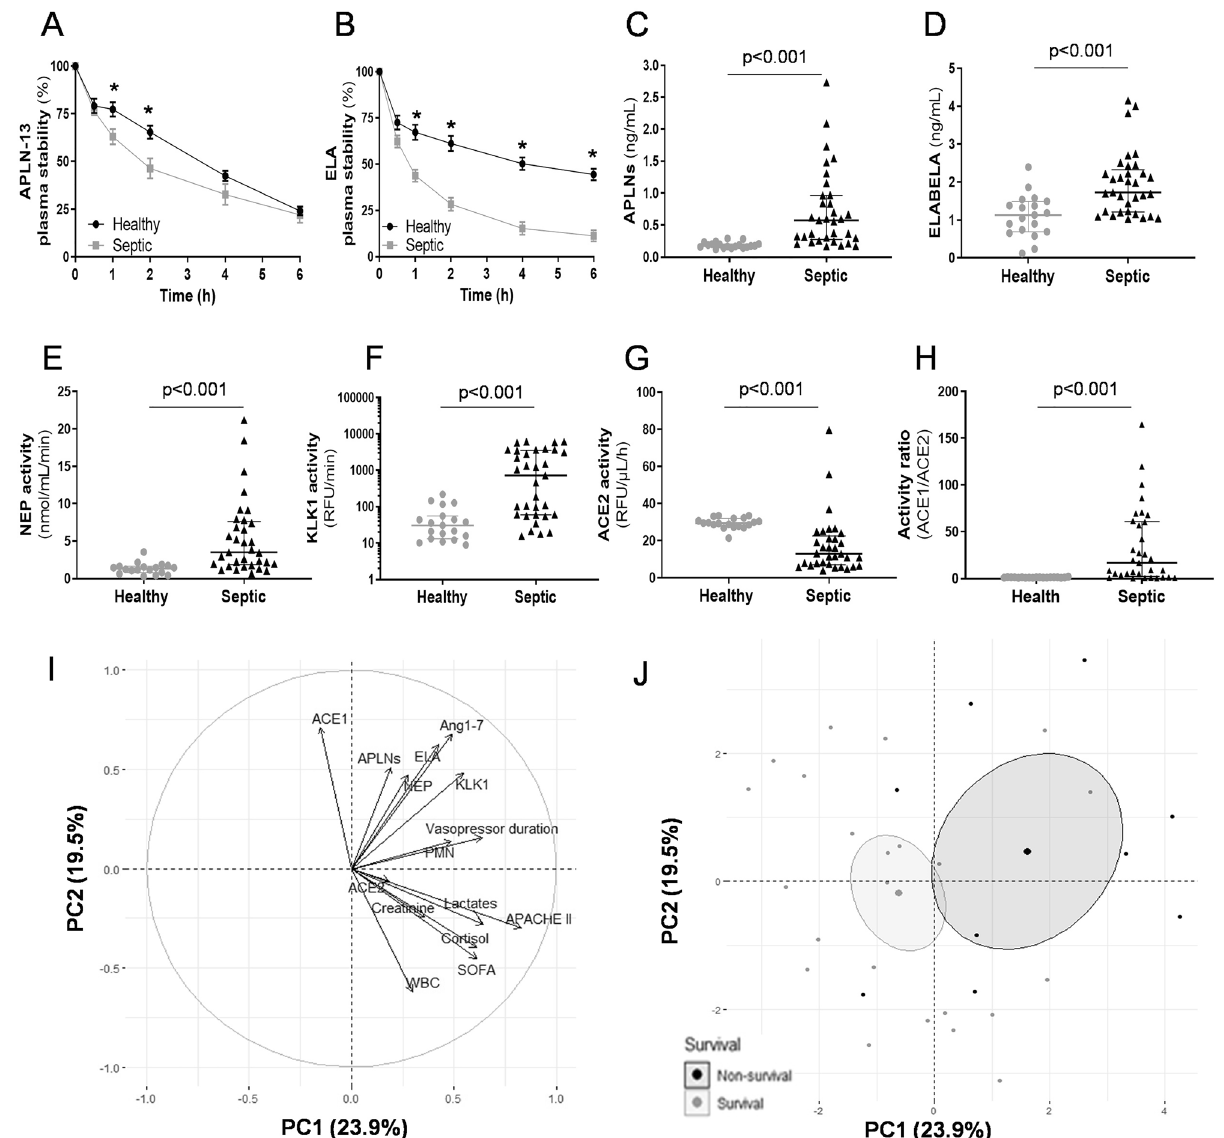
Figure 4. Acute septic shock dysregulated the apelinergic release-degradation rollover and was associated to the activation of specific enzymatic breakdown activities and worsened outcome impacts. A cohort of 33 patients with acute sepsis/septic shock (Sepsis) was included in the study and compared to 19 age-matched healthy volunteers (Healthy) for: (i) assessment of plasma peptide stability; (ii) apelin (APLN) and Elabela (ELA) plasma level determination; (iii) measurement of specific enzymatic breakdown activities; and iv) analyses of the statistical associations between biological; clinical and outcome data. ( A,B ) A randomly selected subset of Sepsis (n = 22) and Healthy (n = 10) plasma were assayed for APLN-13 and ELA stability. The results are expressed as the mean ± SEM. After 1 h incubation, APLN-13 -at two time-points- but also ELA – at four time- points- were more degraded by plasma from septic patients (Sepsis)., *p < 0.05 compared with time-matched values. ( C,D ) Plasma levels of APLNs (all isoforms and moieties) and ELA. Data are displayed as the median [25–75 interquartile range]. Sepsis vs. Healthy induced a higher magnitude of APLN vs. ELA increased levels in bloodstream. ( E–G ) Plasma activities of neprilysin (NEP), kallikrein (KLK1), and angiotensin-converting enzyme 2 (ACE2). ( H ) ACE1/ACE2 enzymatic activity ratio (individual data plots display). Sepsis vs. Healthy enhanced NEP; KLK1; and ACE1/ACE2 enzymatic activity ratio (with decreased ACE2 activity). ( I ) Correlation circle graph of 15 variables related to sepsis outcome from 33 patients and to the apelinergic release-degradation system. Two PCs (PC1 and PC2) were identified in a principal component analysis (PCA), explaining 43% of the variation in the dataset. ( J ) Individual dispersion graph of PCA split by survival status. The midpoint of the concentration ellipses is representative of the gravity center for each modality of survival. Statistical analyses for quantitative variables were performed with a Mann–Whitney U test (nonnormally distributed variables) for panels ( C–H